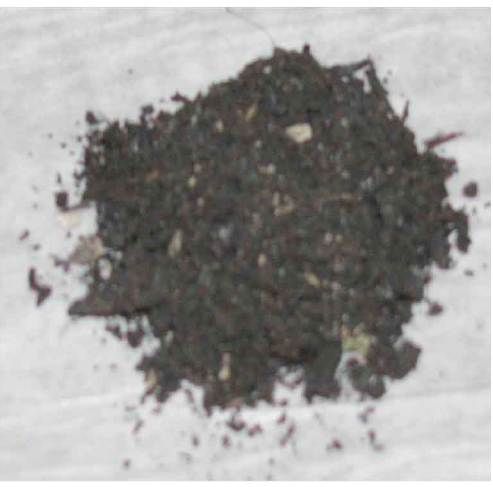
Fig. 1. Charcoal as carrier particle for biofertilizer